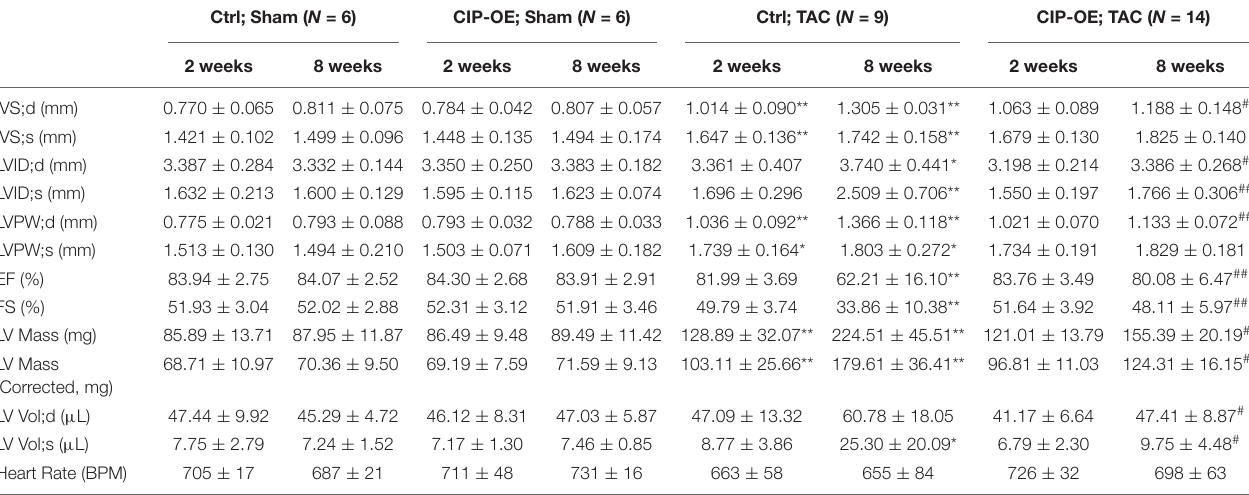
TABLE 1 | Echocardiography examination of cardiac ISL1-interacting protein (CIP)-OE mice and their control littermates with transverse aortic constriction (TAC) or sham operation at different time points after surgery. Ctrl; Sham ( N = 6) CIP-OE; Sham ( N = 6) Ctrl; TAC ( N = 9) CIP-OE; TAC ( N =